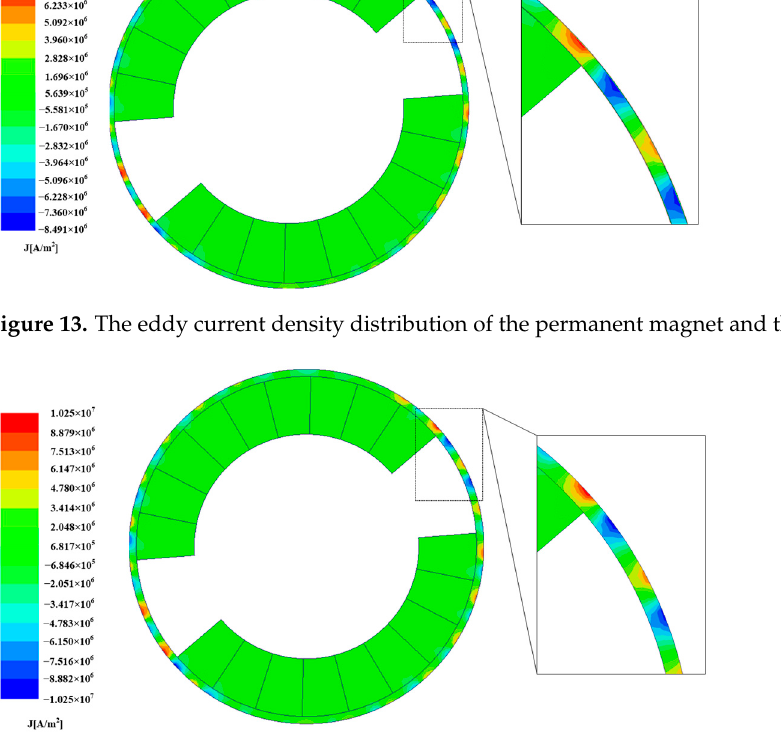
Figure 15. The trend of the maximum eddy current density of the sleeve with different thicknesses.